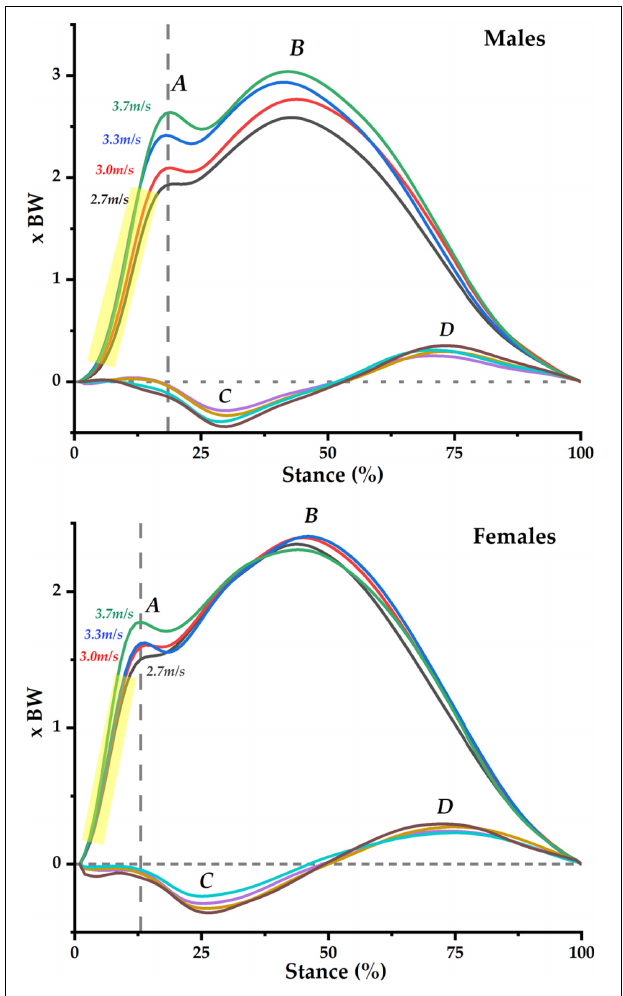
FIGURE 1 | Ground reaction forces in the vertical and anterior–posterior directions across speeds of 2.7, 3.0, 3.3, and 3.7 m/s in male and female runners. First peak (A) and second peak (B) in the vertical GRF and posterior peak (C) , and anterior peak (D) in the ant–post GRF. Yellow highlighted is the 20–80% of the first peak for the calculation of vertical average loading